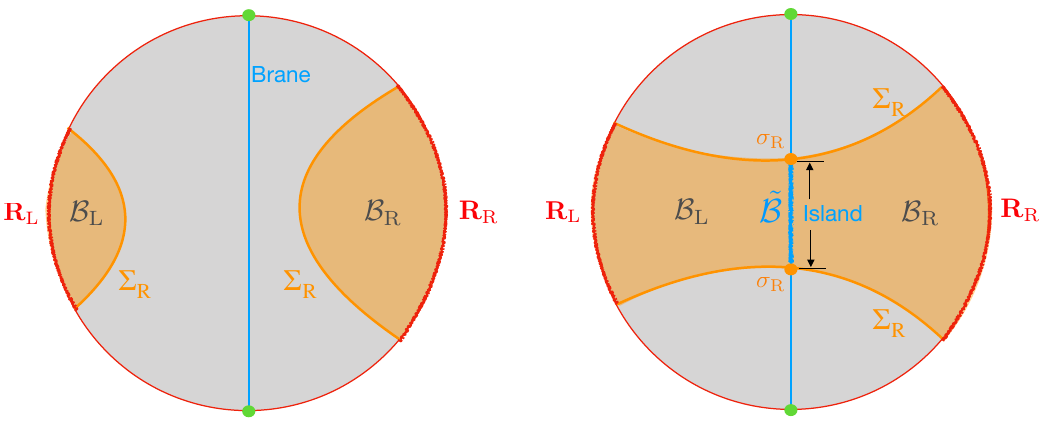
Figure 1 . The choice of RT surfaces for the boundary subregion R = R L ∪ R R on a constant time slice in the presence of the brane (coloured green), showing the island and no-island phases in the right and left panels, respectively. The complexity C sub ( R ) in eqs. (1.2) and (1.5) is determined by V the extremal surface B = B . In the island phase, the intersection of this surface with the L ∪ B R brane defines the ‘island’ e B = B ∩